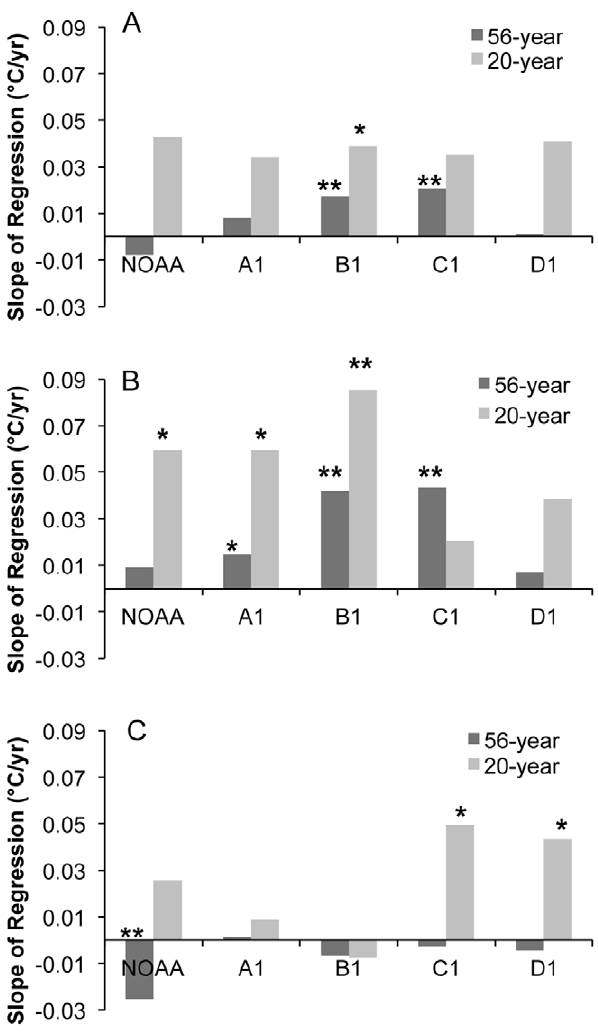
Figure 2. Yearly temperature trends derived by linear regres- sions for the periods of 1953–2008 (56-year) and 1989–2008 (20-year) across the RMFR transect. Trends shown as changes in the average yearly (A) mean, (B) maximum and (C) minimum temperatures ( u C) per year. Significance level of regressions denoted by * p , 0.05, ** p ,